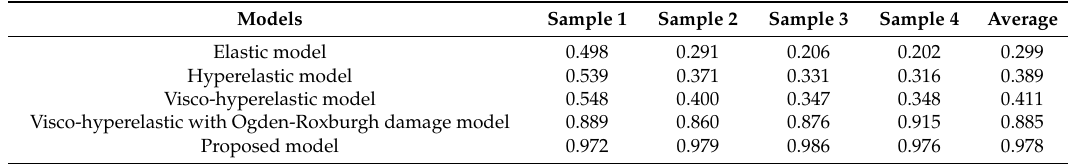
Table 6. Values of R 2 coefficient determined for each constitutive model and experimental